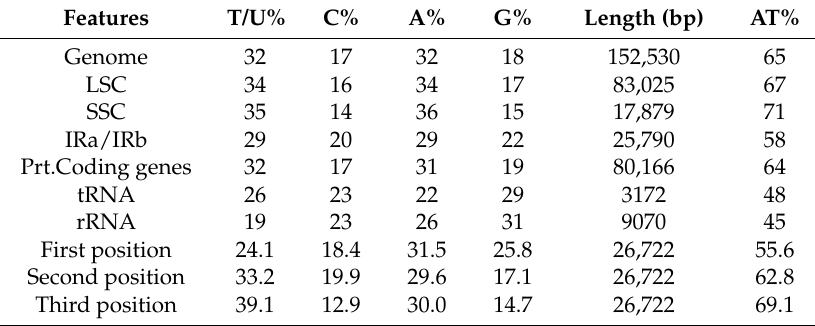
Table 1. Features of the chloroplast genome of Cyamopsis tetragonoloba . T: Thymine; U: Uridine; C;